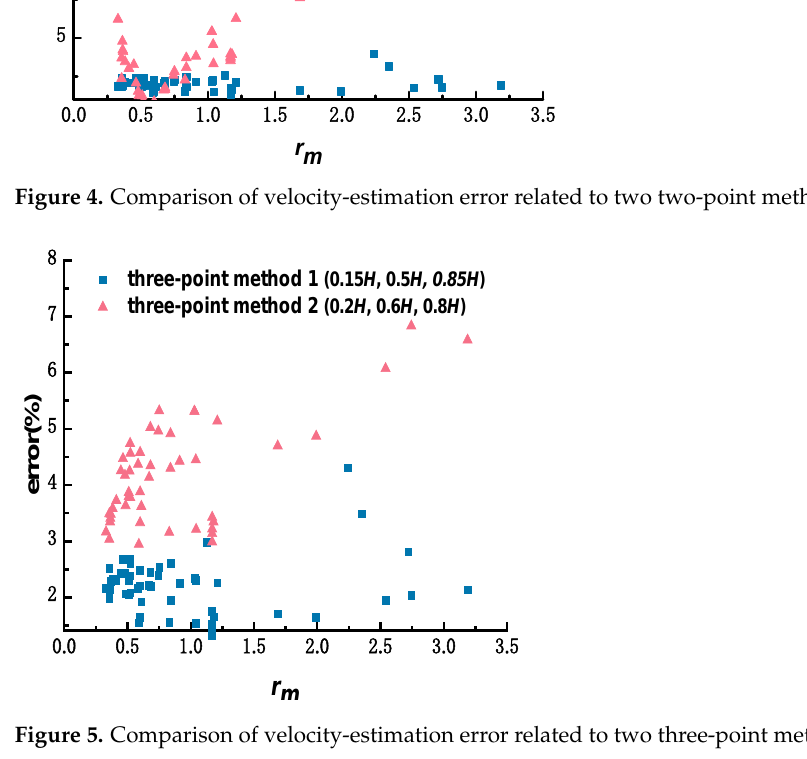
Figure 5. Comparison of velocity-estimation error related to two three-point methods.